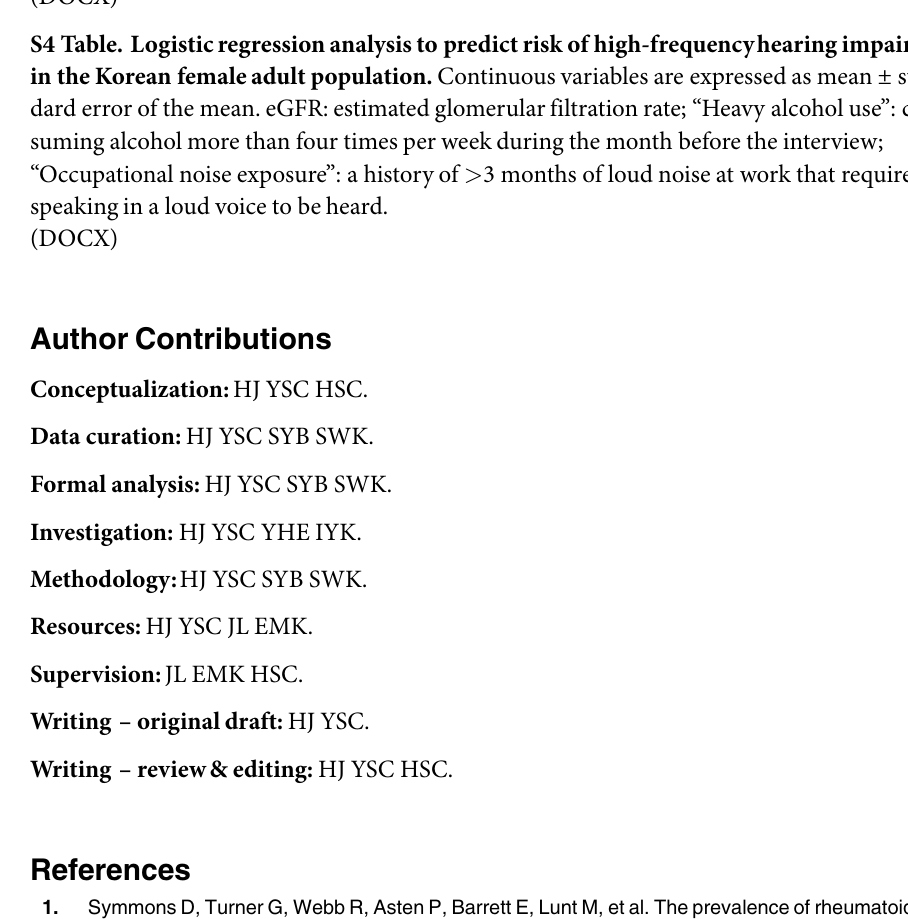
S4 Table. Logistic regression analysis to predict risk of high-frequencyhearing impairment in the Korean female adult population. Continuous variables are expressed as mean ± stan- dard error of the mean. eGFR: estimated glomerular filtration rate; “Heavy alcohol use”: con- suming alcohol more than four times per week during the month before the interview; “Occupational noise exposure”: a history of > 3 months of loud noise at work that required speaking in a loud voice to be